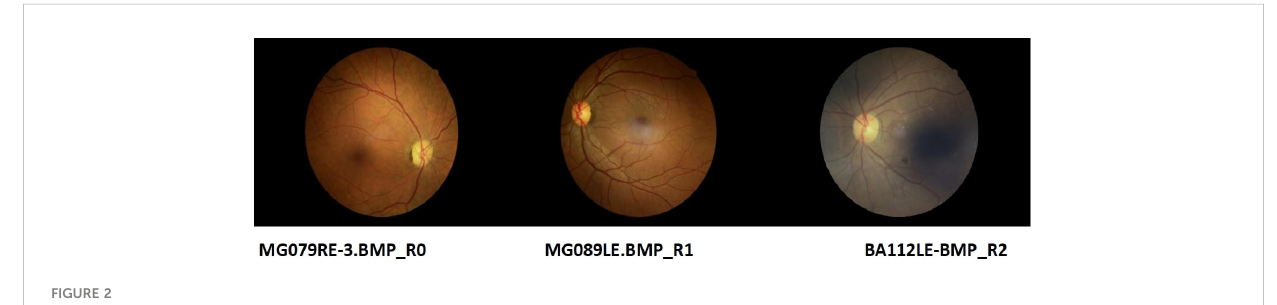
FIGURE 2 Examples of retina images graded.